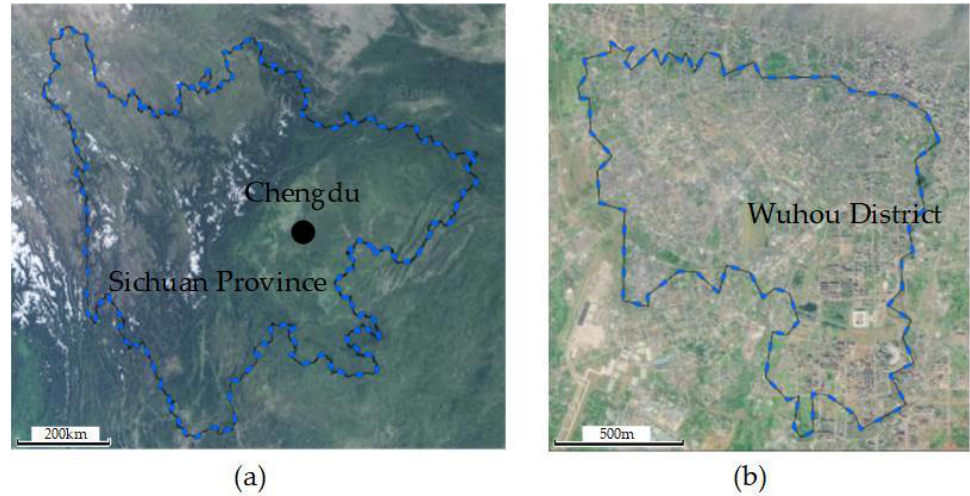
Figure 4. Location of ( a ) Chengdu in Sichuan Province and ( b ) Wuhou District in Chengdu.